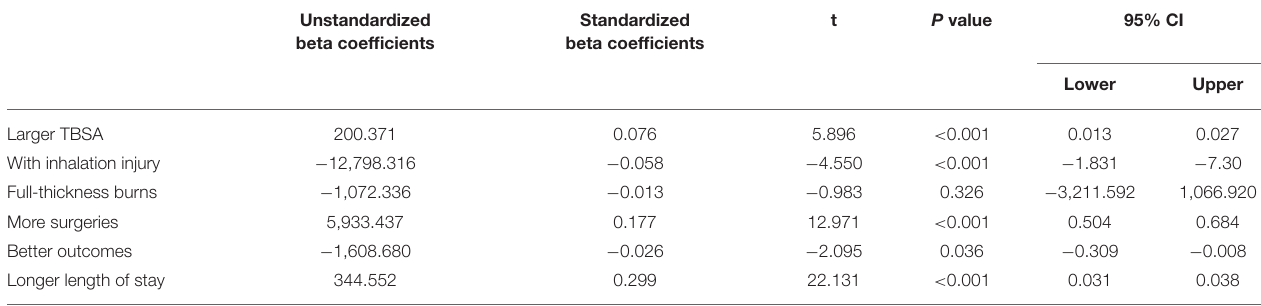
TABLE 6 | Multiple linear regression analysis of related factors of cost.